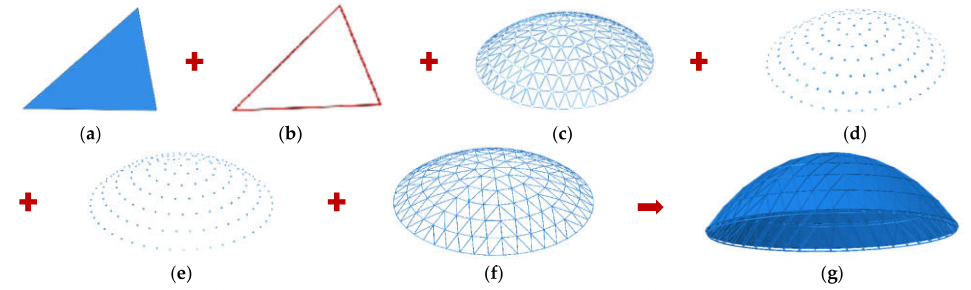
Figure 2. The FEM of spherical reticulated shells with a roofing system adapted from Ref. [16]: ( a ) equiv- alent panel; ( b ) weakened area; ( c ) purlin; ( d ) purlin hanger; ( e ) pillar; ( f ) single-layer spherical reticulated shell; ( g ) reticulated shell structures with roofing